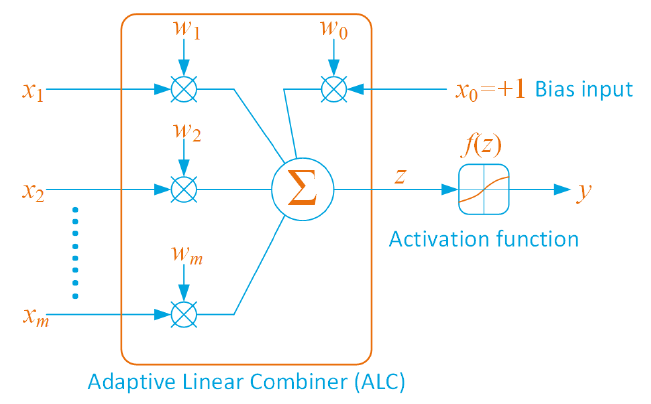
Figure 7. An artificial